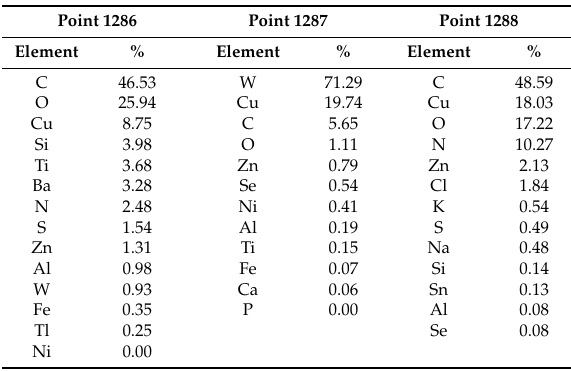
Figure 16. Spectra analyzed in the points of Figure 15. Table 12. Mass of chemical elements at the points analyzed in Figure 15.